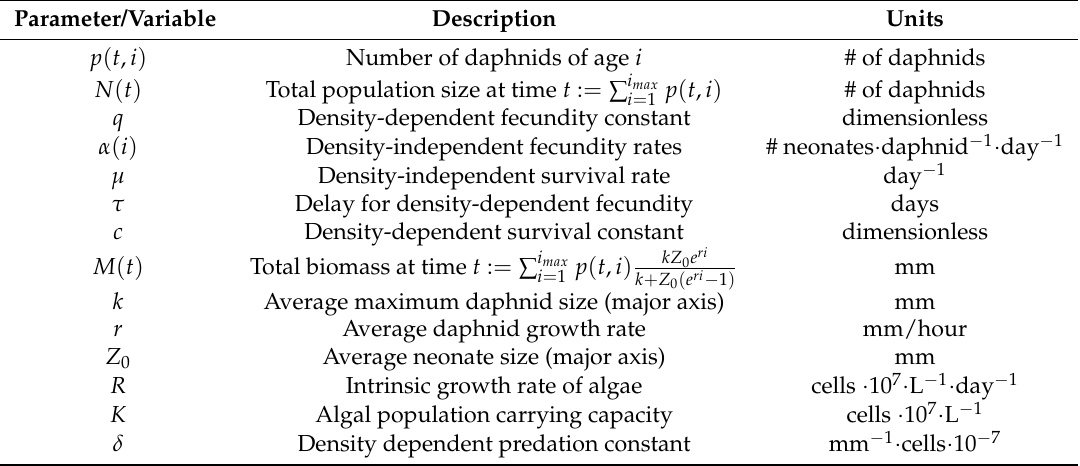
Table 4. Summary of Daphnia magna and algae model parameters and variables.